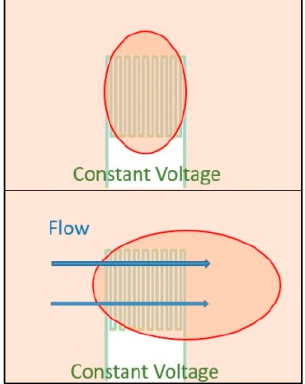
Figure 1. Schematic diagram of sensing with a flexible micro air velocity sensor. The sensing area of the flexible micro air velocity sensor is 400 µ m × 400 µ m. The line width and spacing of the sensor are 15 µ m. The design and mask layouts are shown in Figure 2. The flowchart is shown in Figure 3. Surface micromachining technology was used in the manufacturing process, including coating (Figure 4a), exposure (Figure 4b), development, and lift-off (Figure 4c). The optical micrograph and stereogram of the finished flexible micro air velocity sensor are shown in Figure